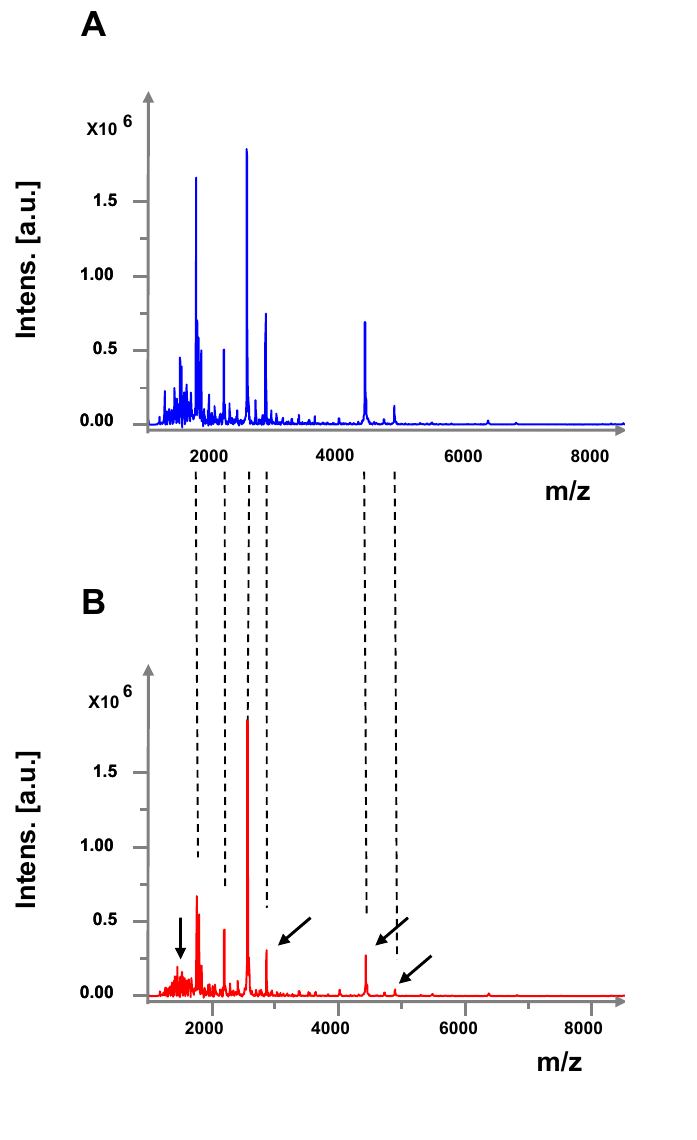
Figure 7. MALDI-TOF analysis of the lipopolysaccharide (LPS) extracted from control ( A ) and GABA-treated ( B ) P. fluorescens MF37. Each figure is a representative example of three different analysis. Arrows indicate peaks particularly modified between control and GABA-treated